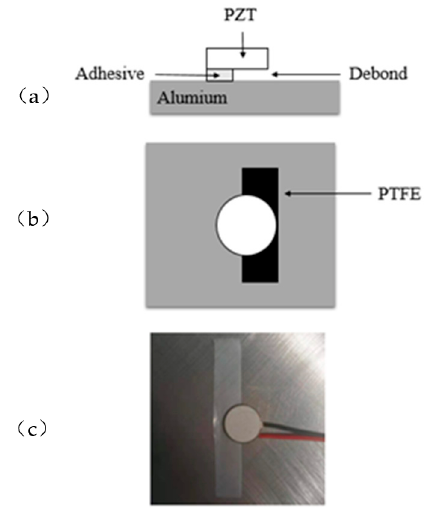
Figure 8. Control method of debonding area and adhesive thickness: ( a ) positive view image; ( b ) top view image; ( c ) actual diagram.